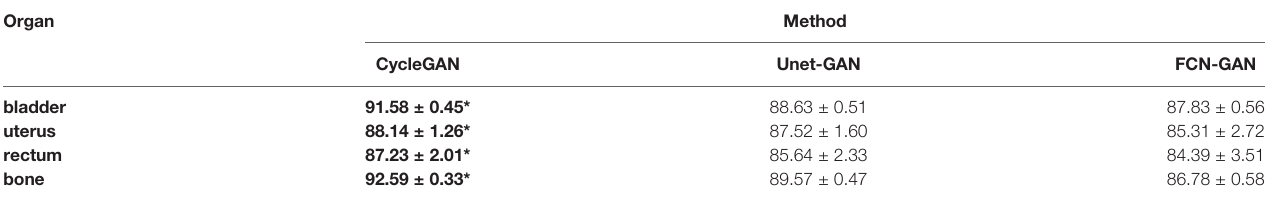
TABLE 2 | DSC (%) measurement results of segmentation accuracy between real CT images and pseudo-CT images synthesized by three different methods. Organ